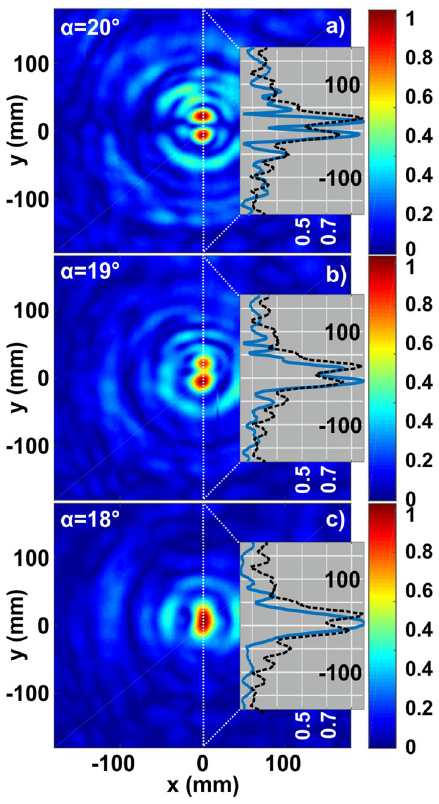
Figure 9. Experimental field intensity distributions (normalized to maximum) obtained at the focal plane of the lens, illuminated from two sources, separated by α = 20°, 19° and 18°. Insets—intensity profiles at the cut through the focal plane center (experiment—blue solid and simulations—black dashed